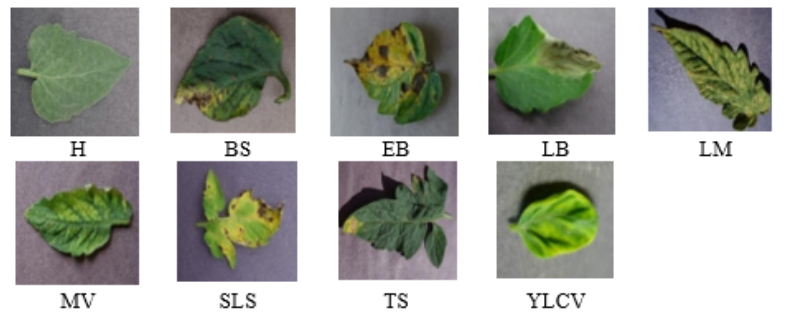
Figure 4. Images of TPL from the PV dataset.